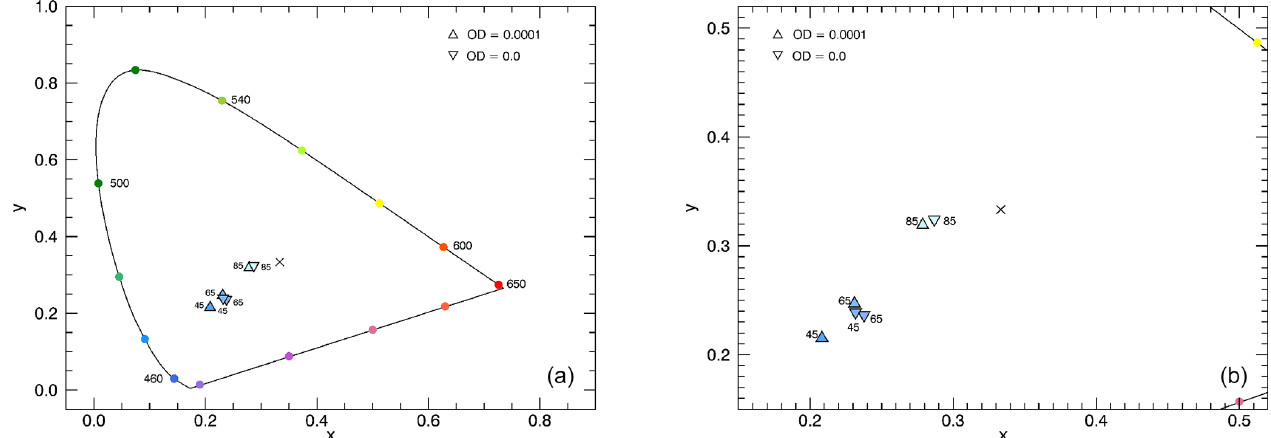
Figure 4. CIE chromaticity diagram corresponding to Fig. 3 with NLCs (OD = 10 − 4 ) and without NLCs (OD = 0). Marked at the data points are the following: VZAs = 45, 65 and 85 ◦ , with SZA = 98 ◦ and SAA = 0 ◦ . Panel (b) shows an enlarged version.